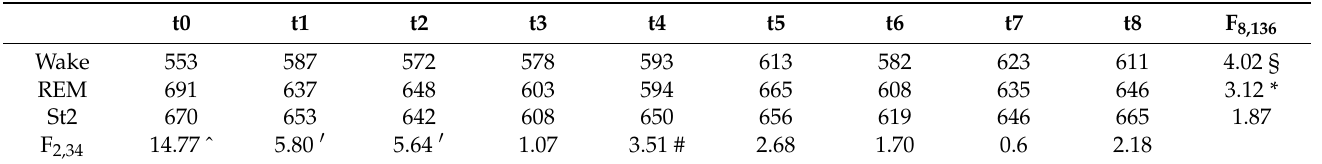
Table 2. Mean values of reaction times in the lexical decision task for experimental conditions (wake, REM awakening, St2 awakening) and experimental trials (from t0 to t8). The last column shows the F values of ANOVAs within condition. The F values of ANOVAs within trial are reported in the last row.